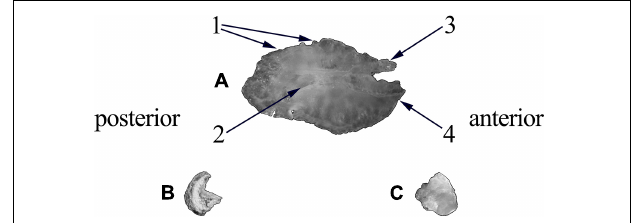
FIGURE 4 | Otoliths extracted from Sparus aurata . (A) Sagitta; (B) asteriscus; (C) lapillus. (1) Dorsal margin with lobes; (2) cauda; (3) antirostrum; (4) rostrum.